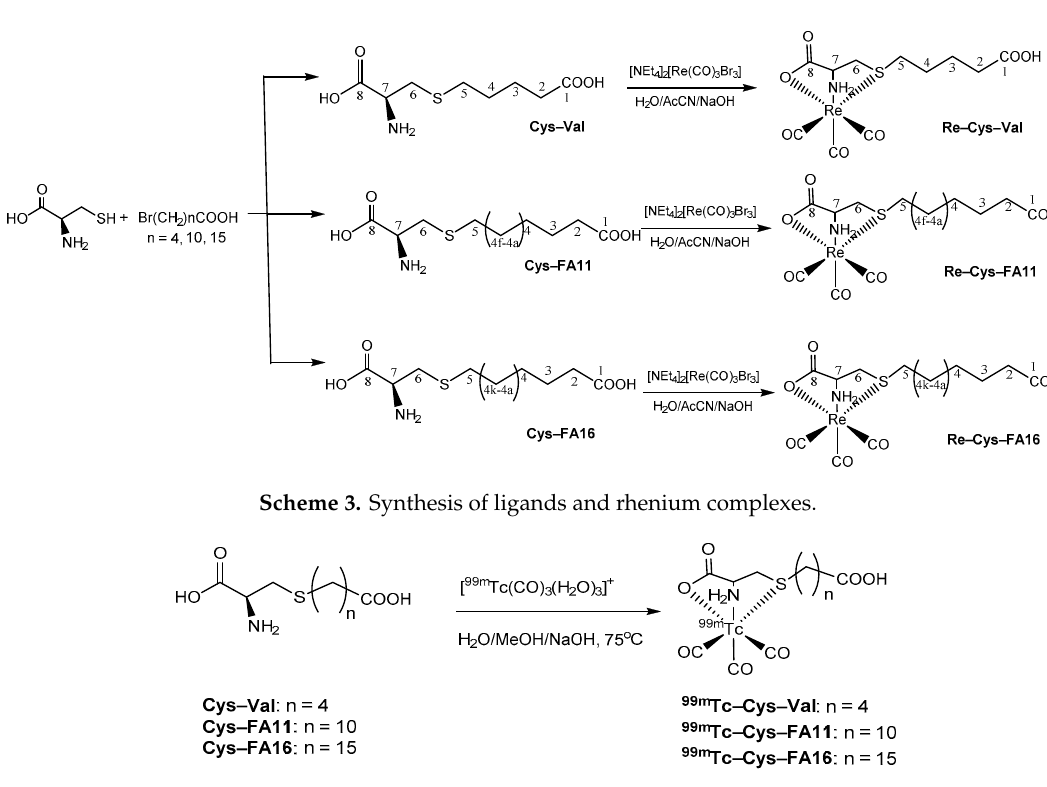
Scheme 4. Preparation of technetium-99m complexes.